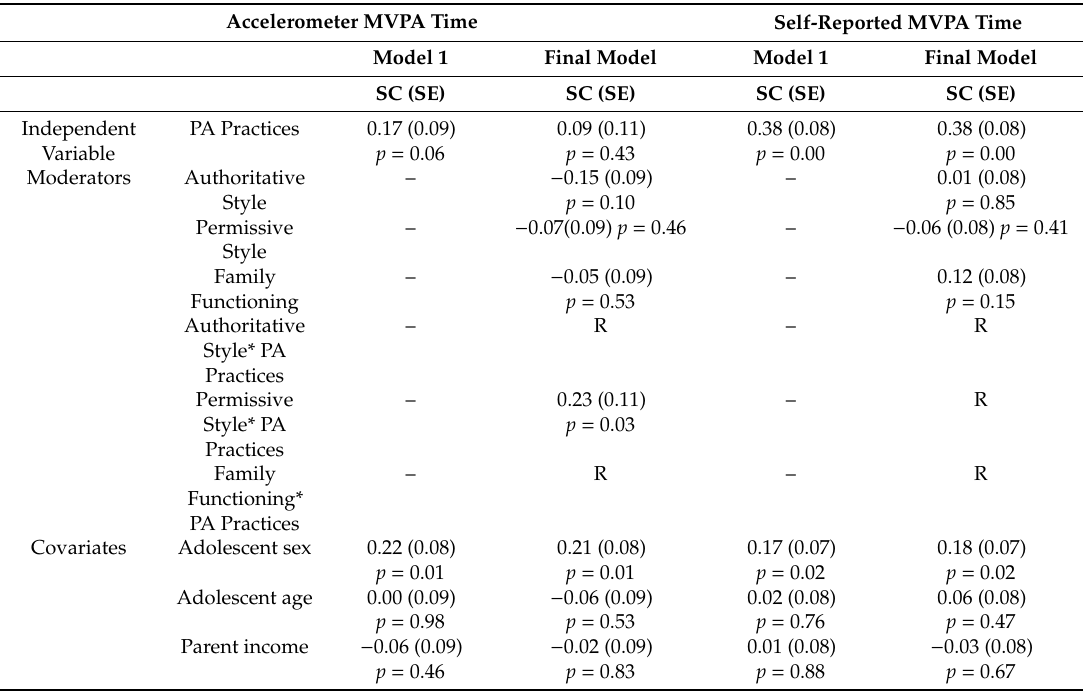
Table 4. Association between physical activity (parenting practices of physical activity) (PA) and adolescents’ accelerometer and self-report of moderate-vigorous physical activity (MVPA).